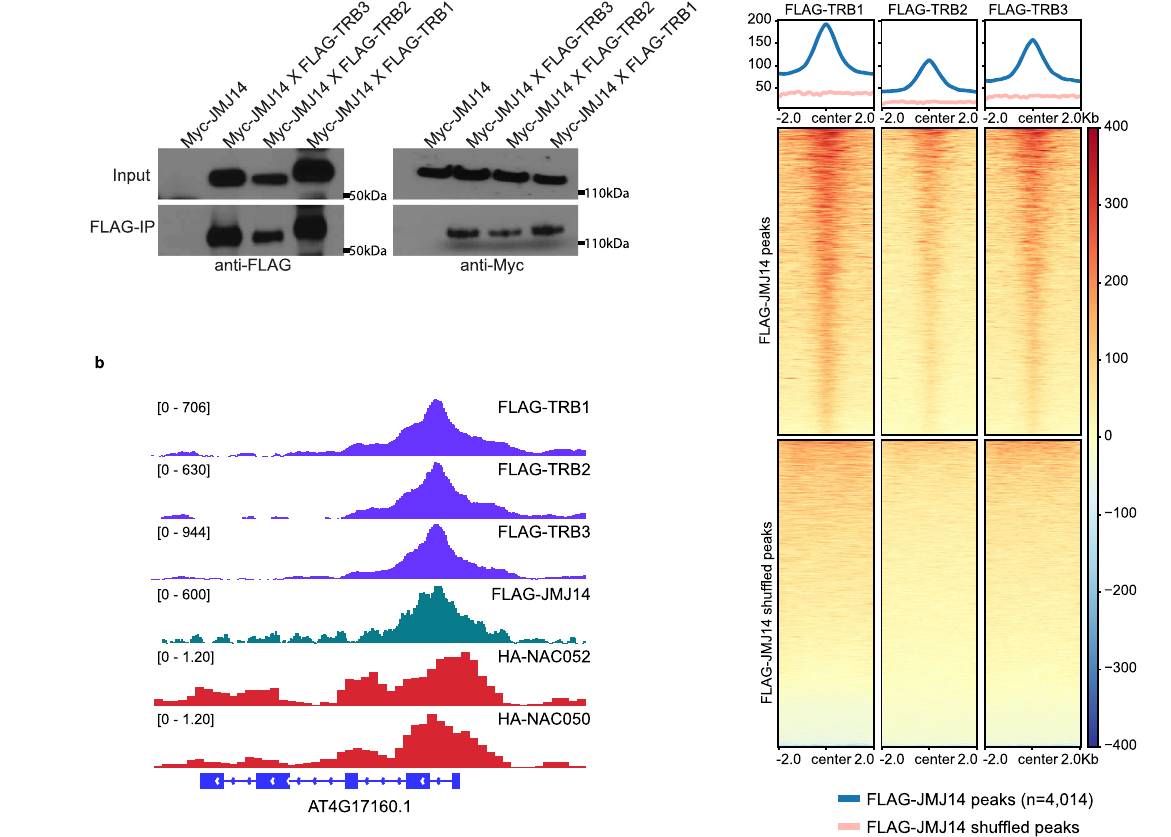
TRB1, FLAG-TRB2, FLAG-TRB3, FLAG-JMJ14, HA-NAC052, and HA-NAC050 over a representative co-bound gene. c Metaplots and heatmaps depicting the ChIP-seq signals of FLAG-TRB1, FLAG-TRB2, and FLAG-TRB3 over FLAG-JMJ14 peaks and shuf fl ed peaks ( n